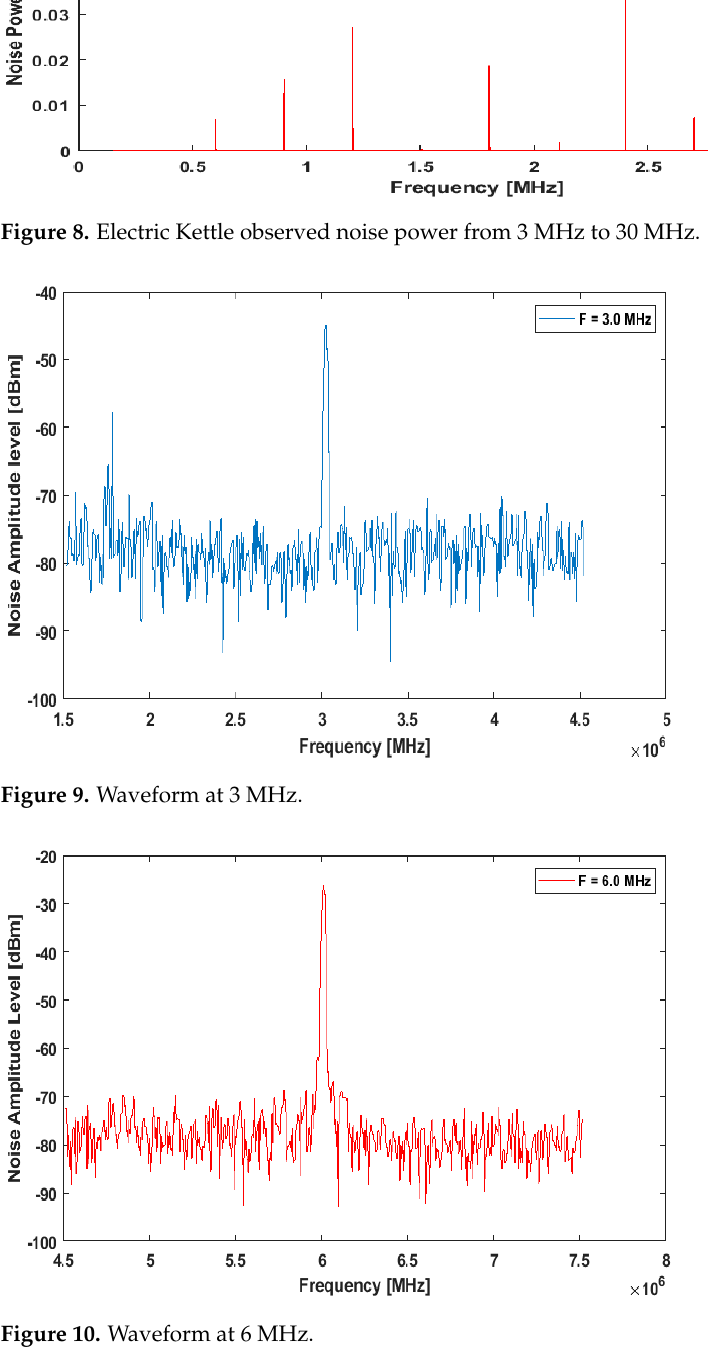
Figure 10. Waveform at 6 MHz.